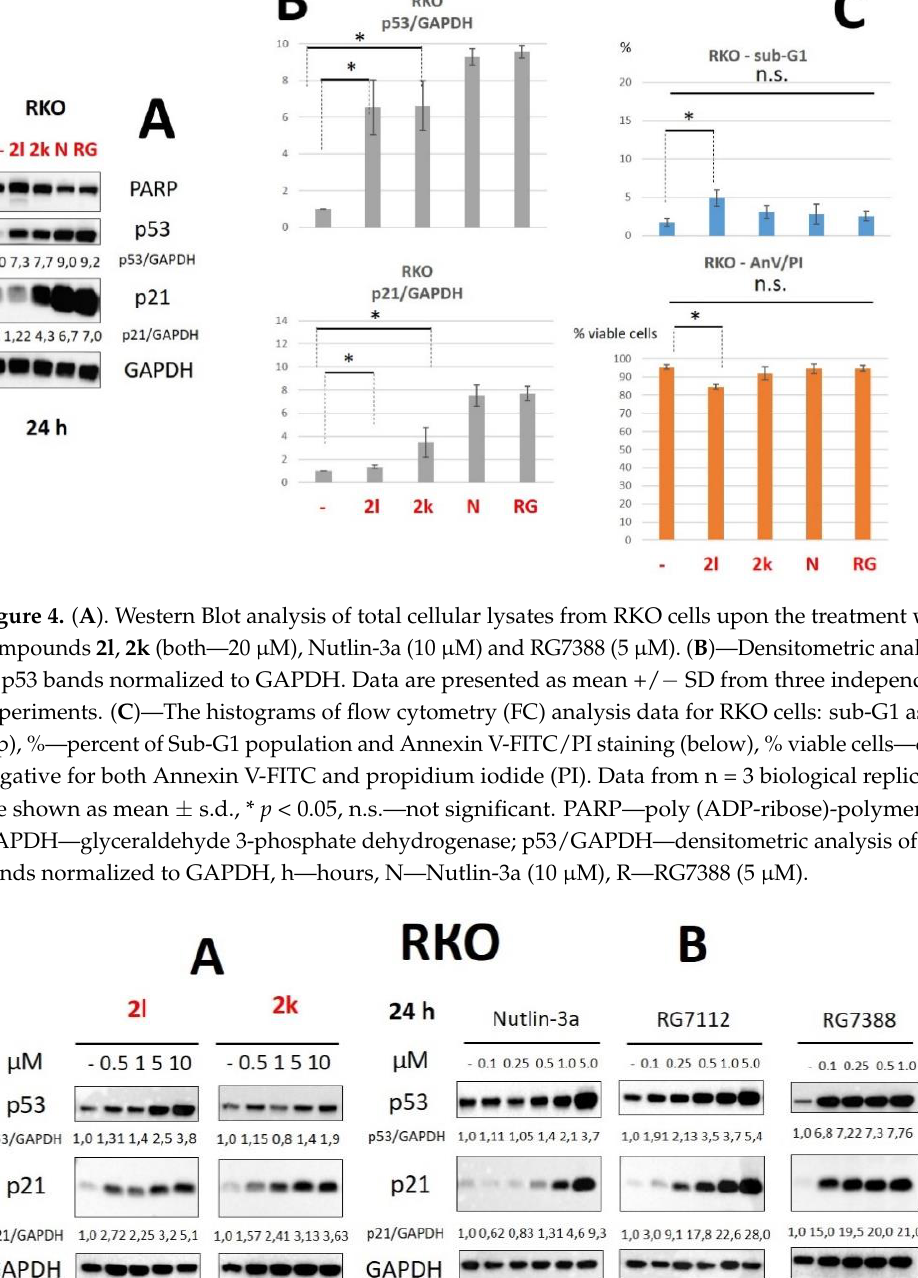
Figure 5. Western Blot analysis of total cellular lysates from RKO cells upon treatment with 2l , 2k ( A ); Nutlin-3a, RG7112 and RG7388 ( B ). GAPDH was used as a loading control. Designations: GAPDH— glyceraldehyde 3-phosphate dehydrogenase; p53/GAPDH and p21/GAPDH—densitometric analysis of p53 or p21 bands normalized to GAPDH.